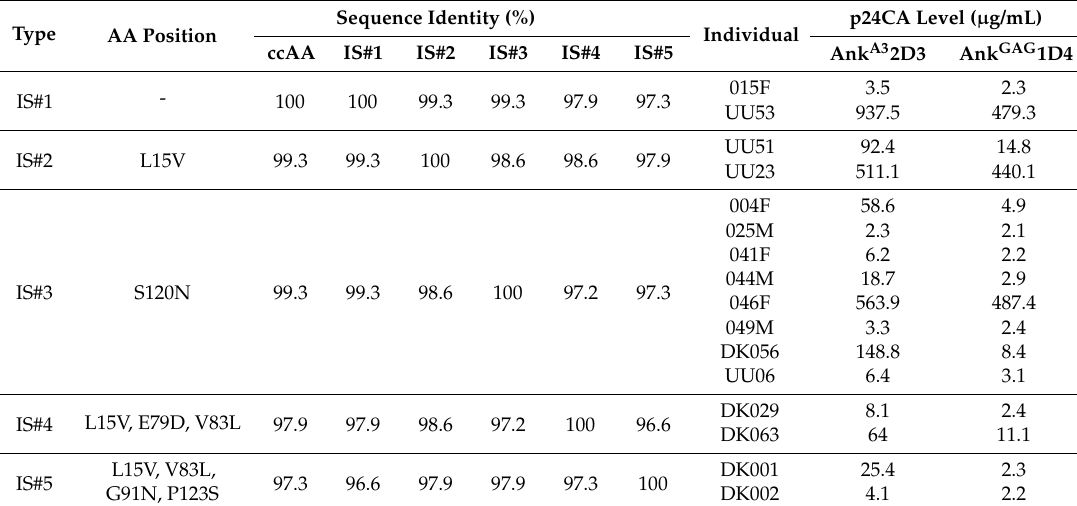
Table 1. Sequence Identity of Five Identical Sequences in 16